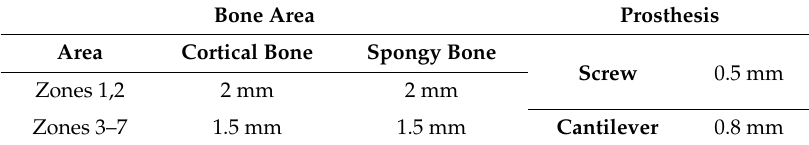
Table 3. Dimensions of the elements in the various components of the biomechanical system.